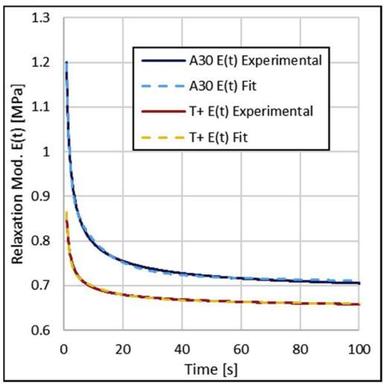
Relaxation modulus of our Prony series prediction overlaid on the experimental results of A30 and T+ from a 100 s relaxation test.